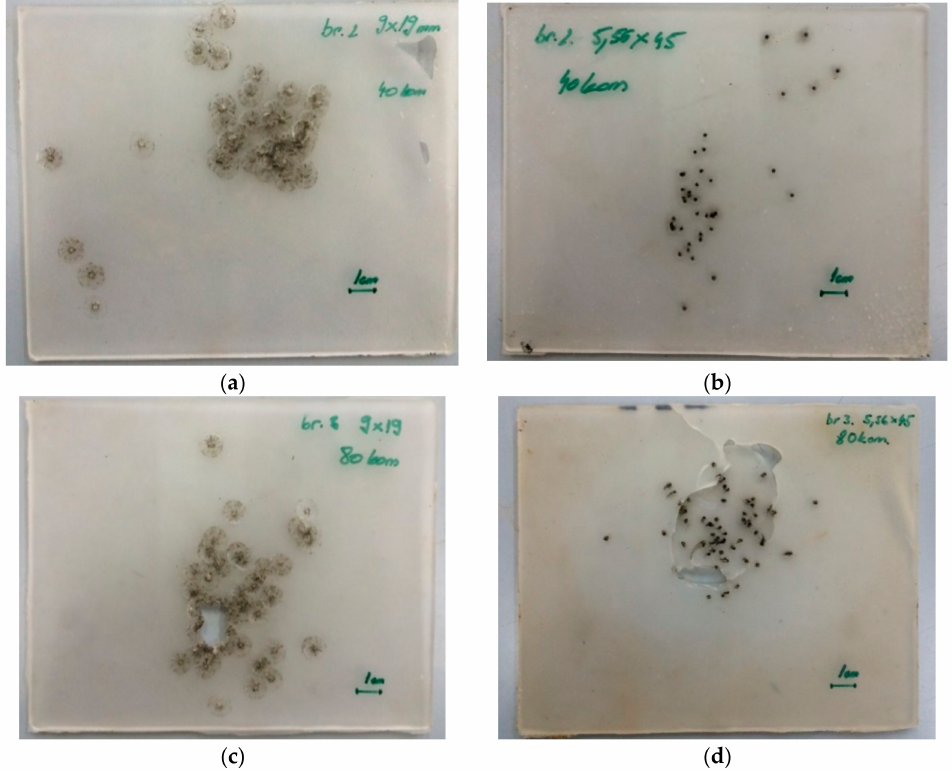
Figure 6. Ballistic tests with different calibers, ( a , c ) 9 mm and ( b , d ) 5.56 mm. The tests ( a , b ) were performed with 40 shots and ( c , d ) with 80 shots (the scale in the lower right corner shows 1